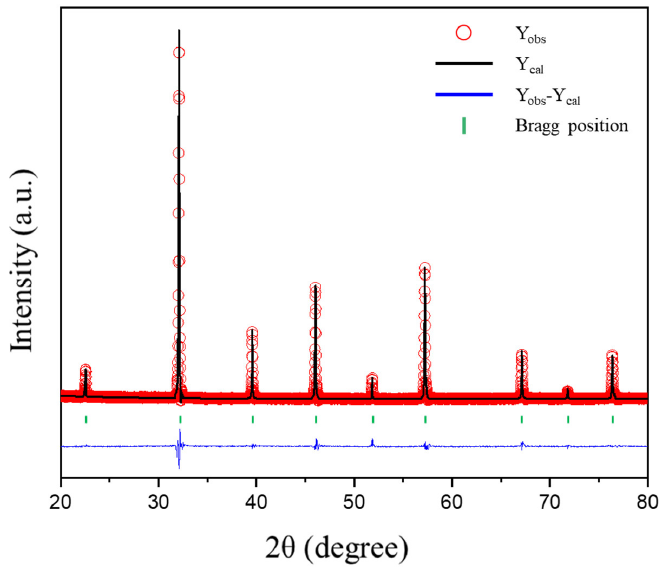
Figure 2. Rietveld refinement result of the Ba 0 . 5 Sr 0 . 5 Fe 0 . 85 Cu 0 . 15 O 3−δ after calcination at 950 °C for 10 h in air. The open symbol is observed intensities, the black line is calculated intensities, the blue line is the difference between the observed and the calculated intensities, and green vertical bars are Bragg positions. Table 1. Structural parameters of the Ba 0 . 5 Sr 0 . 5 Fe 1-x Cu x O 3−δ (x = 0, 0.05, 0.10, 0.15) calculated by Rietveld refinement of the room-temperature XRD data.